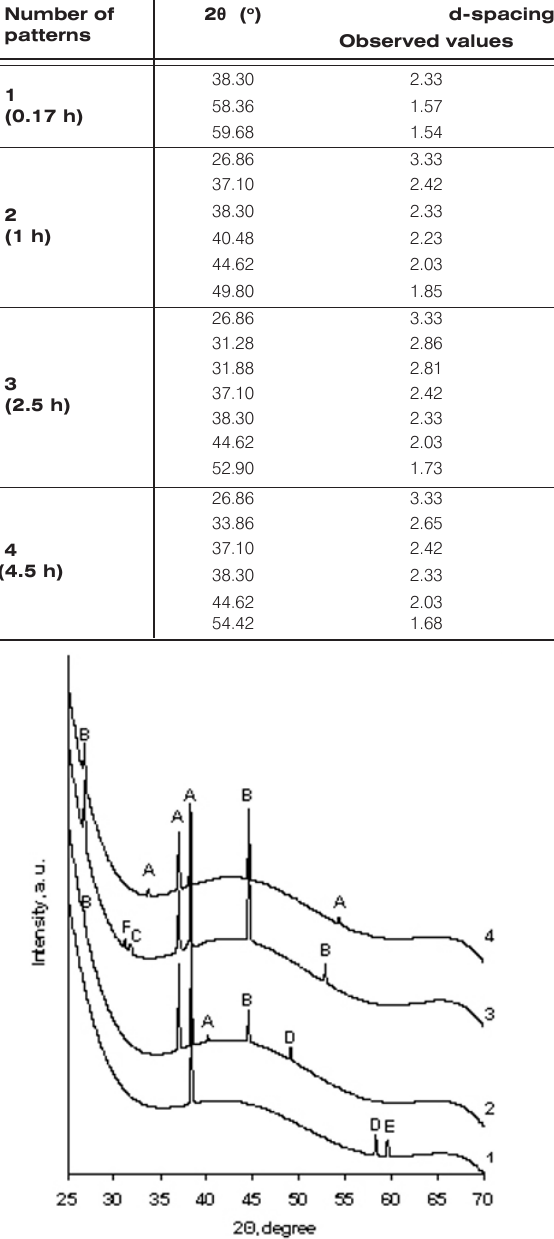
Figure 3. XRD patterns of the Cu Se layers on PA films formed x by the sorption-diffusion method with different period of seleniumization. Period of seleniumization, h: 1 – 0.17, 2 – 1.0, 3 – 2.5, 4 – 4.5. A – Cu Se 2